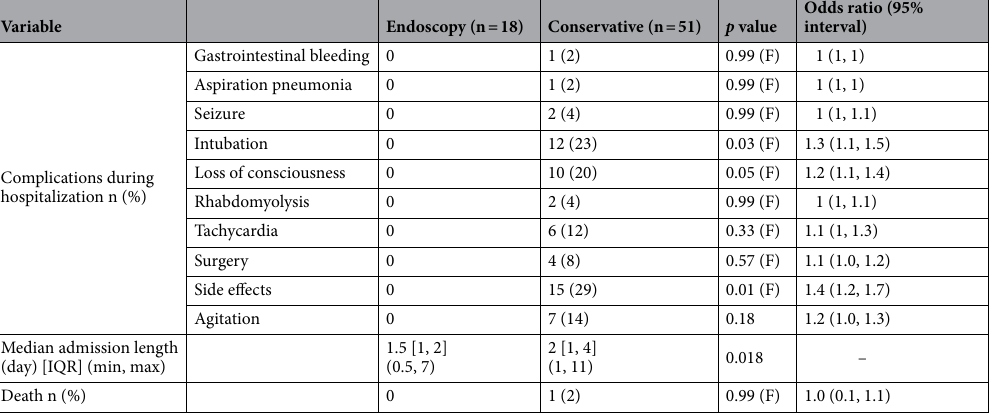
Table 2. Clinical outcomes of body stuffers (n =